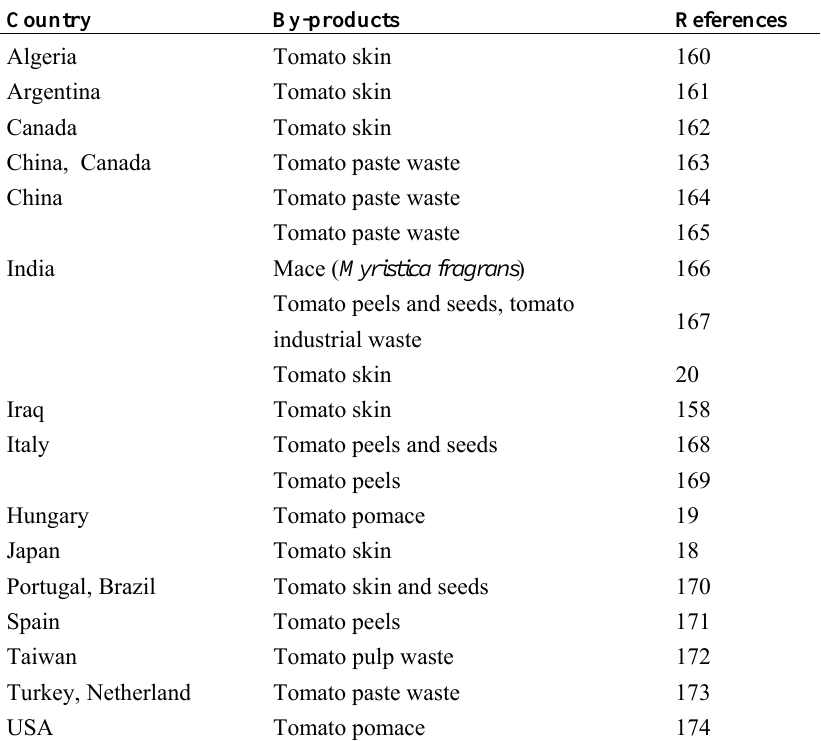
Table 4. Studies on lycopene from by-products.